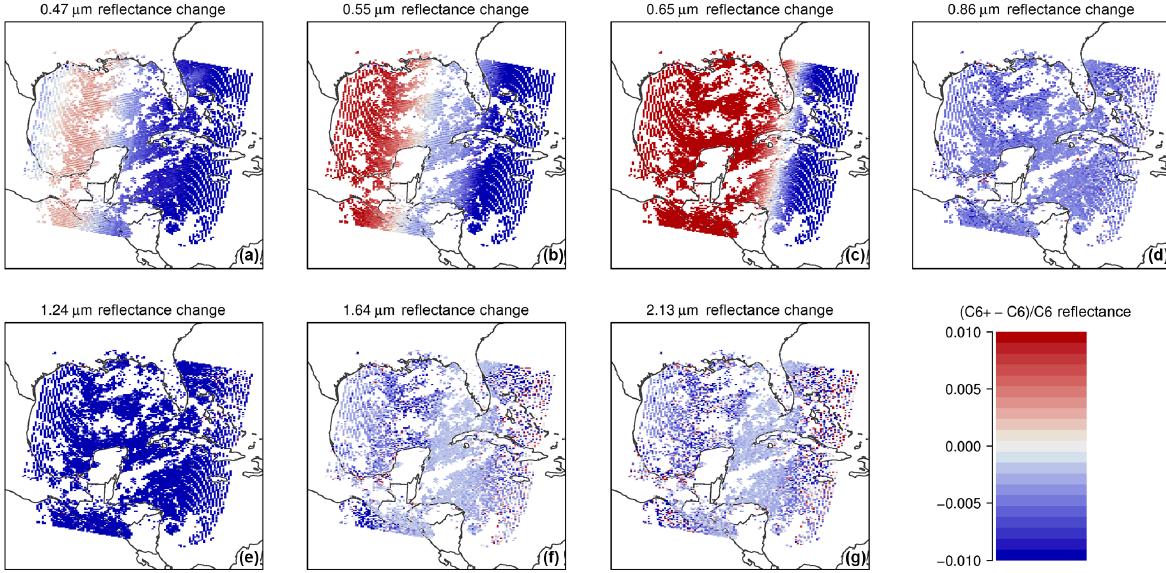
Figure 10. Impact of applying C6 + calibrations to MODIS-T reflectance data on 25 July 2008 at 16:25UTC. Relative differences in each wavelength